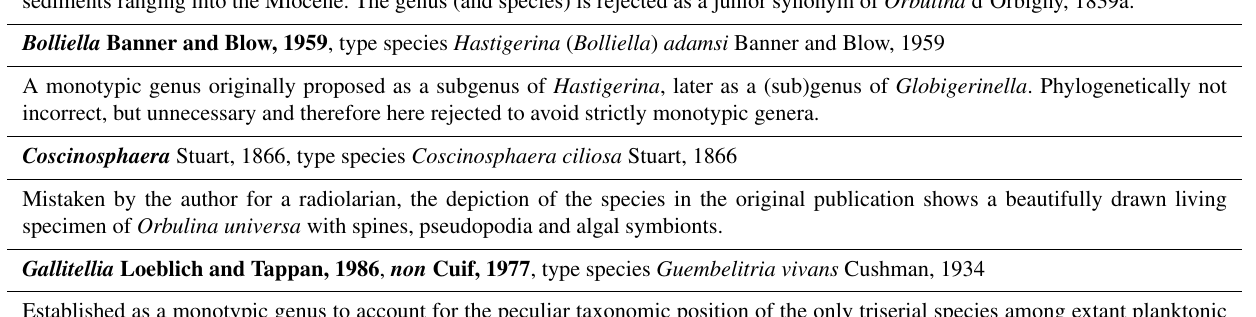
Table 1. Annotated list of genera previously used in the taxonomy of living planktonic foraminifera but rejected in the present revision. Alloglobigerinoides Huang, 1986 , type species Globigerina conglobata Brady, 1879 A monotypic genus erected by Huang (1986) to account for a presumed absence of an umbilical primary aperture on the final chamber in the type species. Whilst there are specimens where the final chamber does obscure the aperture, there are also many specimens where the primary aperture is visible, making the diagnostic character of the genus obsolete in lieu of Globigerinoides . Biorbulina Blow, 1956 , type species Globigerina bilobata d’Orbigny, 1846 A monotypic genus based on a species representing a morphological variant found in living Orbulina universa , which generally forms only one spherical chamber but may occasionally form a second, hemispherical chamber partially encompassing the previous